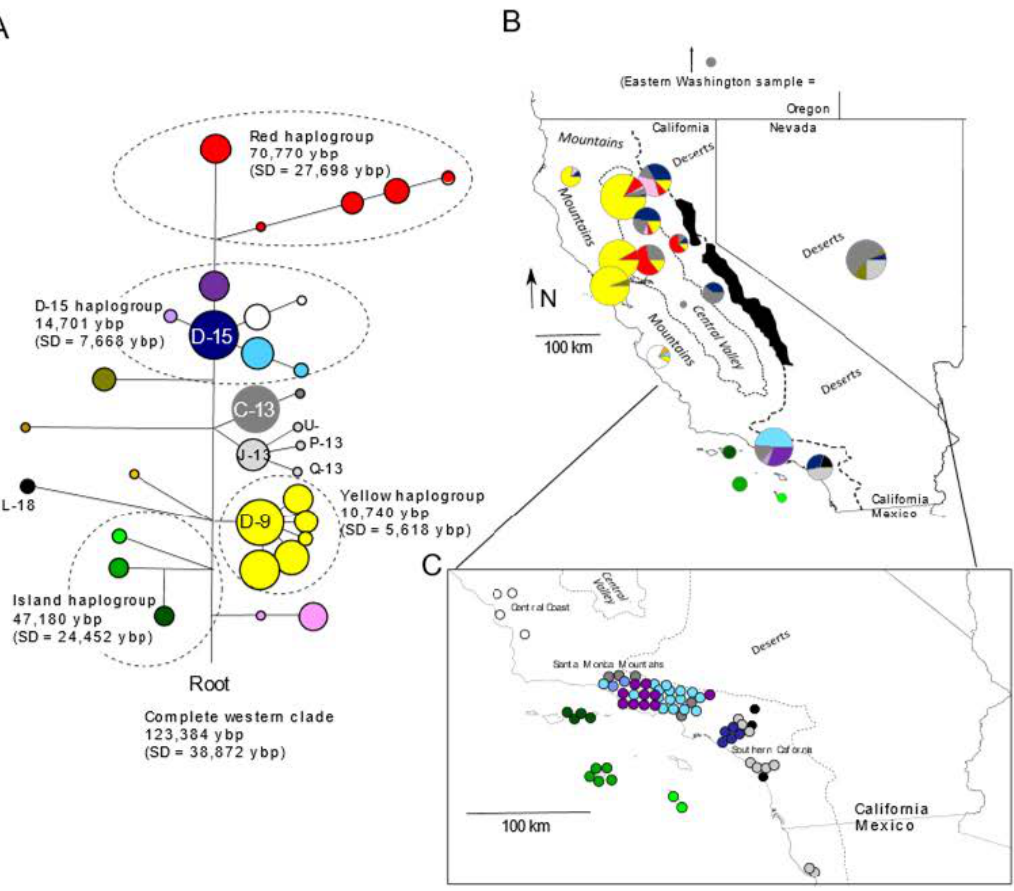
Figure 2. Mitochondrial diversity in gray foxes ( Urocyon cinereoargenteus ) and island foxes ( U. littoralis ) in the California Floristic Province and the Desert ecoregion separated by the Pacific Crest